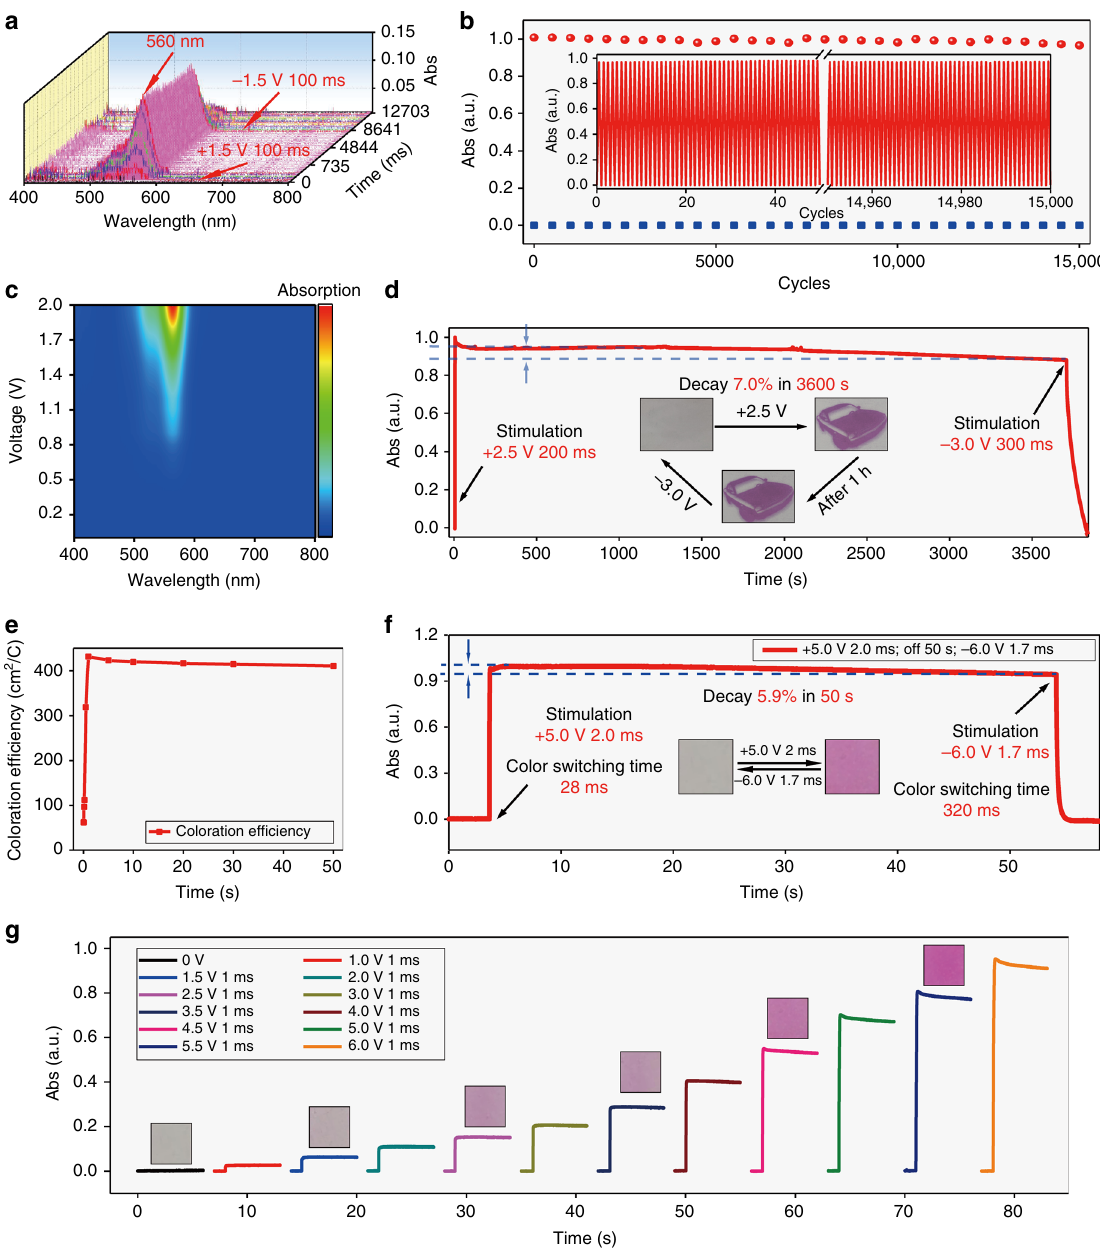
Fig. 2 Electrochromic properties of solid devices. a Their absorption from 400 to 800 nm measured by fi ber optical spectrometry under + 1.5 V 100 ms, power off 8 s, − 1.5 V 100 ms. b The stability of the device under stimulation of + 1.0 V 0.6 s, wait 1.0 s, − 0.5 V 1.4 s, wait 3.0 s. c The absorption spectra of the device under different voltages for 200 ms. d The absorption at 560 nm under stimulation of + 2.5 V 200 ms, power off 3600s, − 3.0 V 300 ms. Inset: pictures of the bistable device. e Coloration ef fi ciency of the device. f The absorption of solid Li – Na fi on bistable device at 560 nm under + 5.0 V 2.0 ms, power off 50 s, − 6.0 V 1.7 ms. g Absorption spectra of the Li – Na fi on device at 560 nm under different voltages for 1 ms. Inset: pictures of the Li – Na fi on device under different